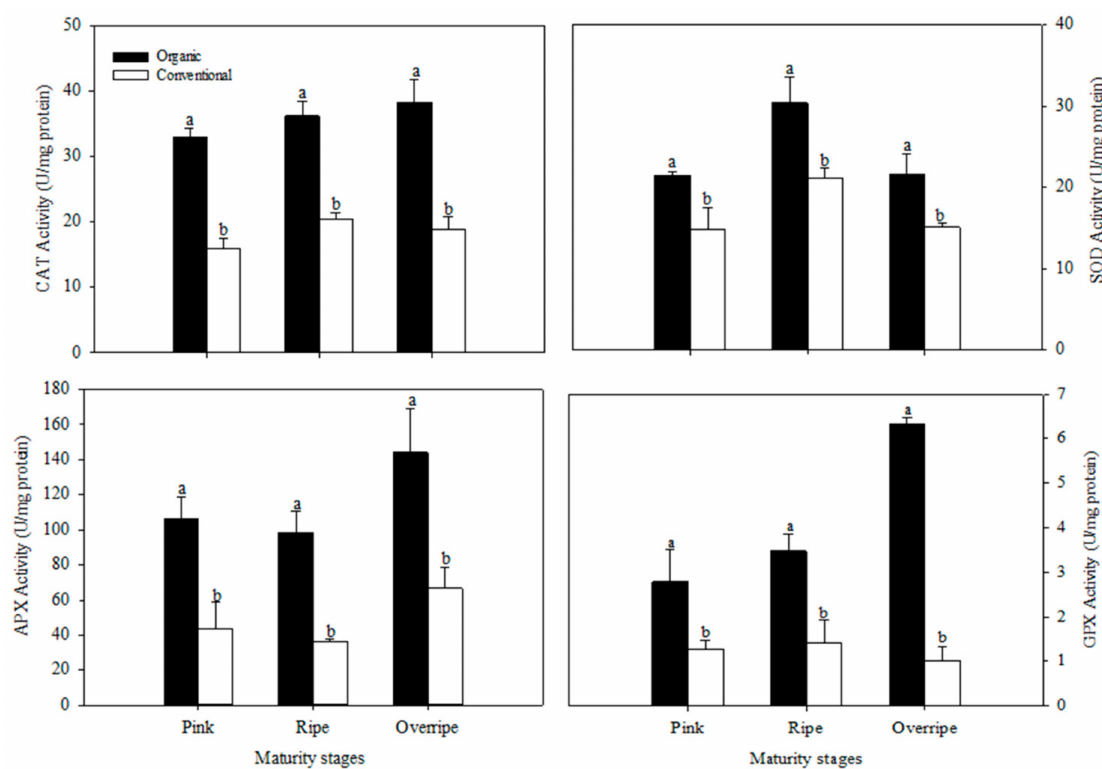
Figure 2. Effect of the fertilization system on catalase (CAT), superoxide dismutase (SOD), ascorbate peroxidase (APX), and glutathione peroxidase (GPX) in fruits at three stages of maturation. The results are represented as means ± standard deviation. Different letters between maturity stages indicate statistical difference ( p ≤ 0.05).